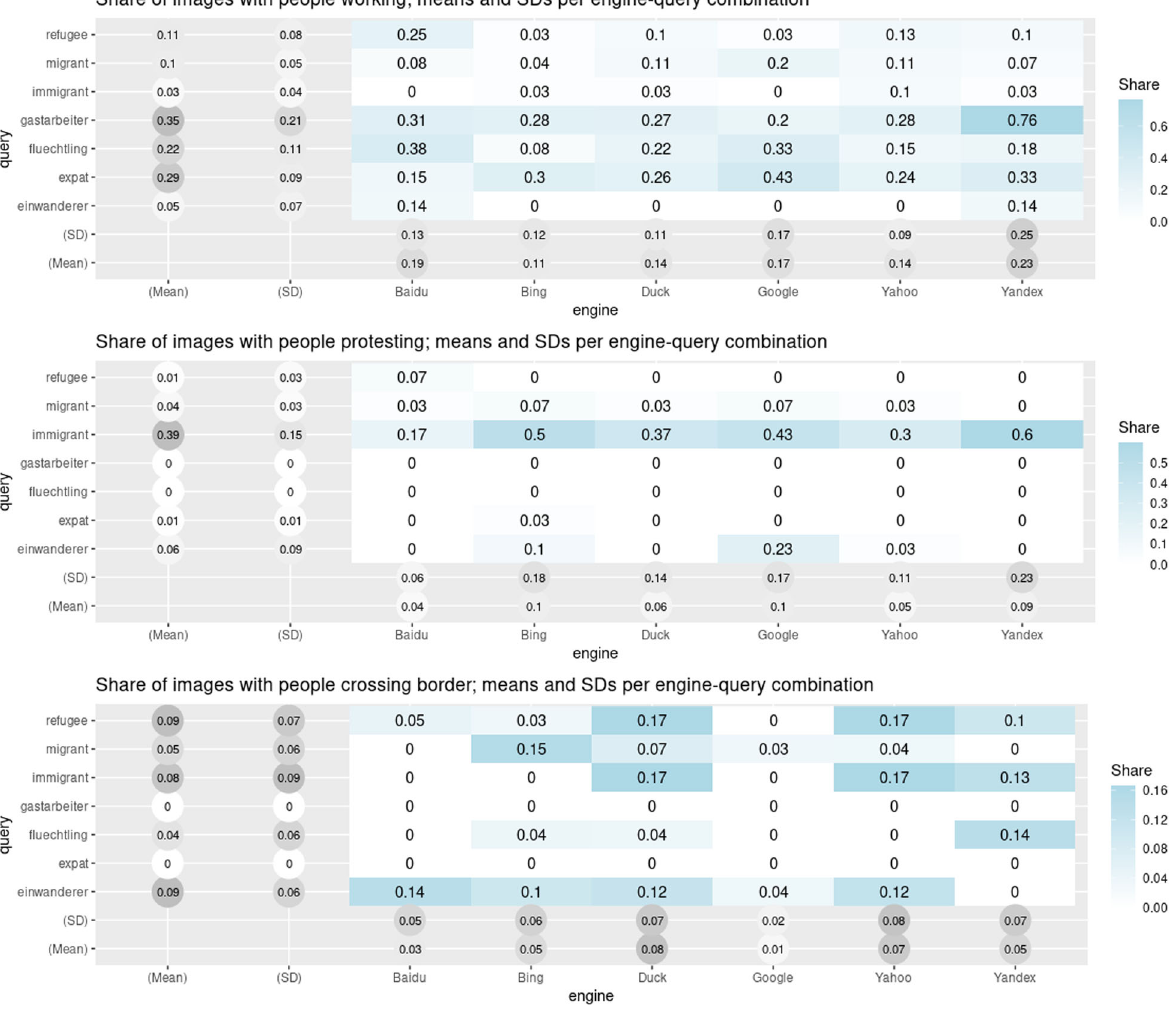
Fig. 8 Share of images with people engaging in different activities. Share of images with people engaging in different activities (work, protest, border crossing) by search engine and